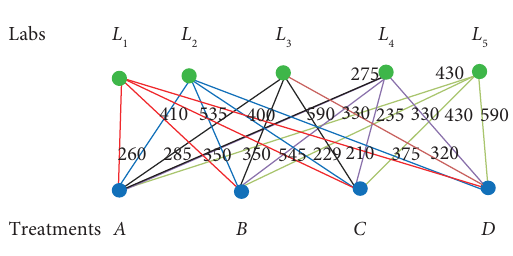
Figure 2: Second bipartite graph.